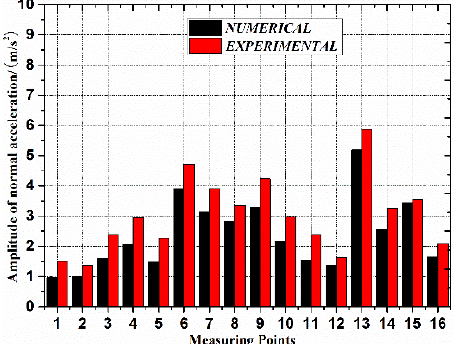
Appl. Sci. 2019 , 9 , x FOR PEER REVIEW Figure 11. The compassion of numerical and experimental amplitude of normal acceleration.